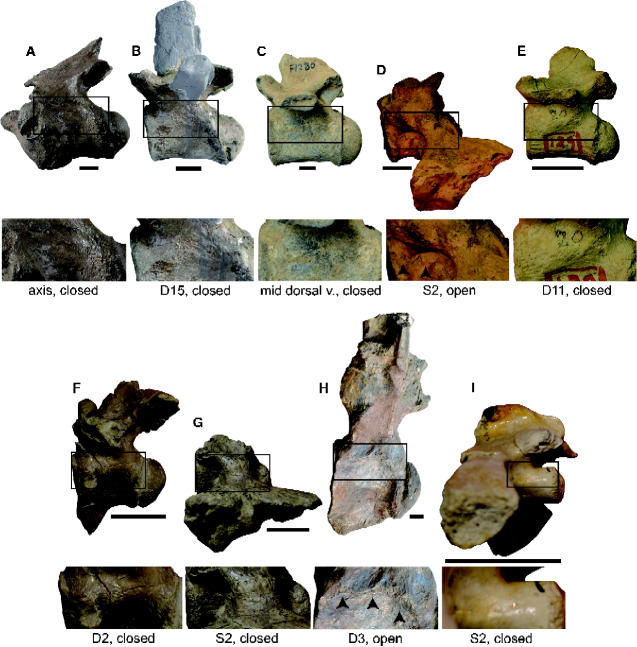
States of neurocentral suture closure in selected vertebrae of (A) Toyotamaphimeia machikanensis (MOU F00001), (B) Penghusuchus pani (NMNS 005645), (C) Gavialinae sp. indet. (MZKB F1280), (D) “Crocodylus” affinis (YPM 258), (E) “Crocodylus” grinnelli (YPM 1344), (F) Boverisuchus vorax (USNM 12957), (G) Borealosuchus wilsoni (USNM 12990), (H) Deinosuchus riograndensis (AMNH 3073), and (I) Pachycheilosuchus trinquei (USNM 427794). D, dorsal; S, sacral. Enclosed areas are enlarged below for each vertebra. Arrows represent open sutures. Scale bars equal 2 cm.